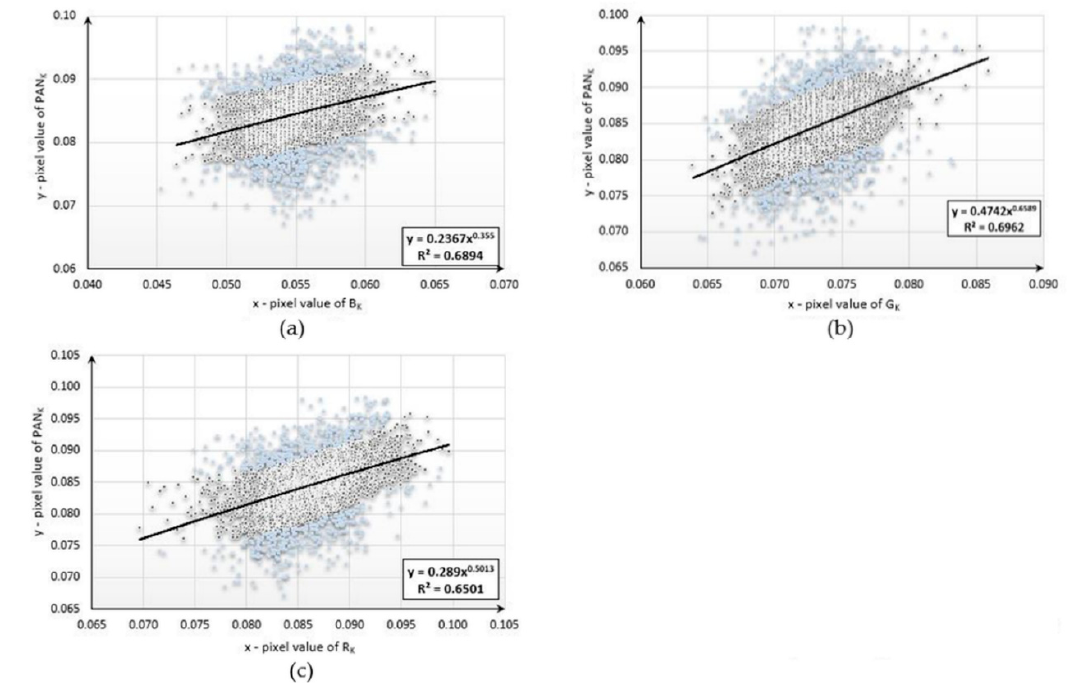
Figure 6. Diagrams presenting the functional relationships for the bare soil sample: ( a ) between PAN and red bands; ( b ) between PAN and green bands; ( c ) between PAN and blue bands. and red bands; ( b ) between PAN and green bands; ( c ) between PAN and blue